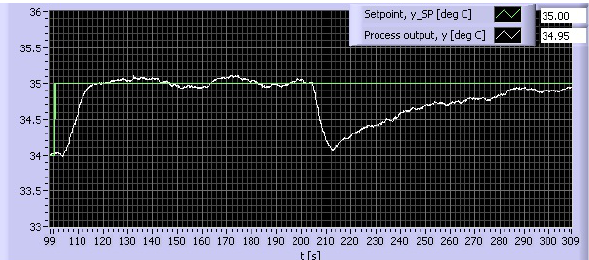
Figure 17: Setpoint Overshoot method: The responses in the control system.